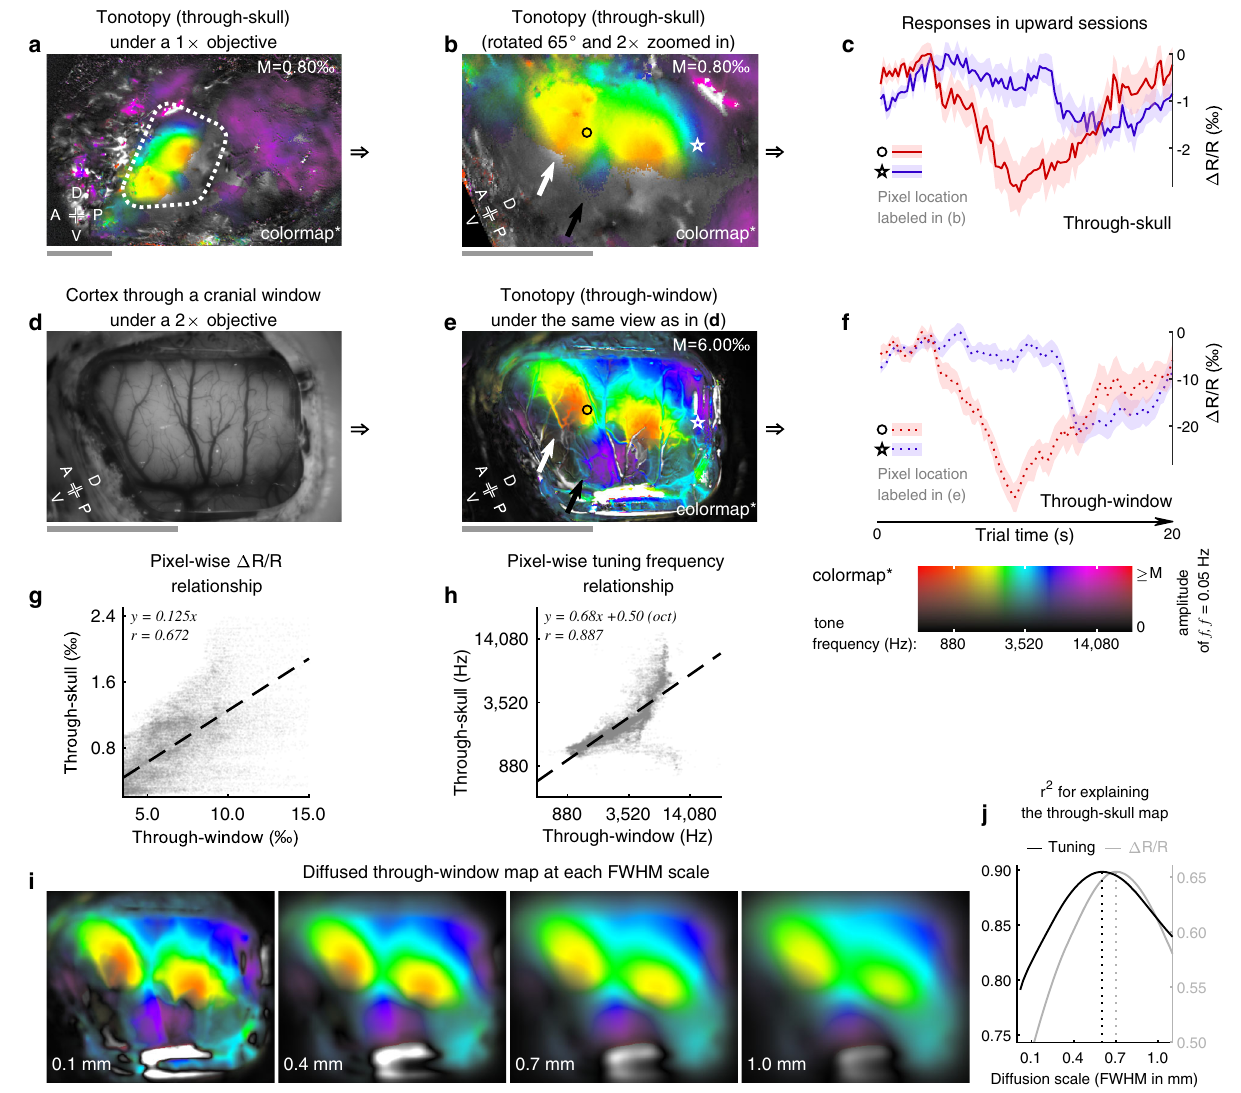
Fig. 4 Comparison of tonotopic maps acquired through-skull or without the skull. a The tonotopic map imaged through-skull in subject M8E under a 1× objective. The dotted contour indicates the location of a subsequently implanted cranial window ( d ) to target the entire auditory cortex on the brain surface. b The 2× zoomed-in map of ( a ). The white (black) arrow indicates the location of the low- (high-) frequency end of the newly described tonotopic gradient (see also Fig. 3h). The locations of two exemplar pixels are labeled with a circle and a pentagram. c , f Trial responses from the exemplar pixels labeled in ( b and e ) during the upward tonotopy mapping session imaged through-skull ( c ) or through-window ( f ). Solid-colored lines: mean responses; shades: SEMs ( n = 20 cycles). d A cranial window implanted over the location of the tonotopic gradients seen in ( a , b ). Imaging was performed under a 2× objective. Both the lateral sulcus and the superior temporal sulcus are apparent and match their positions estimated through-skull. e The tonotopic map imaged through the window as in ( d ). The arrows indicate the newly described tonotopic gradient as in ( b ), whereas the circle and the pentagram mark approximated positions of the two exemplar pixels labeled in ( b ). g The scatter plot for comparing pixel-wise response amplitudes through-skull and through-window. Linear model fi tting: F -statistic = 2.94 × 10 4 , p -value = 0 ( n = 35679 pixels). h The scatter plot for comparing pixel-wise turning frequencies through-skull and through-window. Linear model fi tting (in octave): F -statistic = 1.32 × 10 5 , p -value = 0 ( n = 35679 pixels). i Arti fi cially diffused through-window maps at various scales. j Linear model fi tting results across diffusion scales. The goodness-of- fi t is given as the r-squared value 2 between the diffused through-window map and the through-skull map, for both response amplitude and tuning frequency. The upper display limit of response amplitude “ M ” is listed at the top right in each map ( a , b , e ). The 2D colormap for these maps is shown below ( f ). Scalebars in ( a , b , d , e ): 5 mm. A: anterior; P: posterior; D: dorsal; V: ventral. Imaging was performed in the right hemisphere and the results were mirrored for display